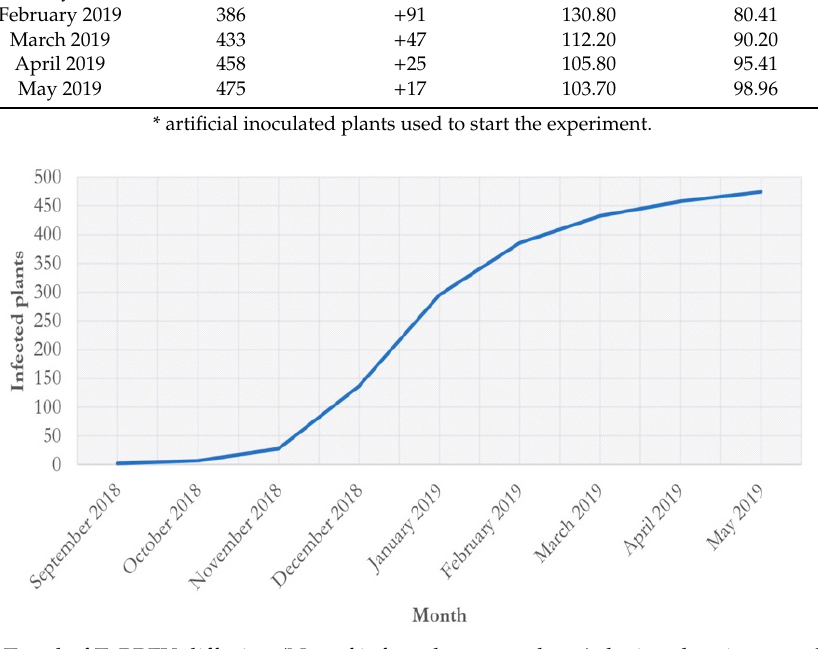
Figure 4. Trend of ToBRFV di ff usion (No. of infected tomato plants) during the nine months inside the